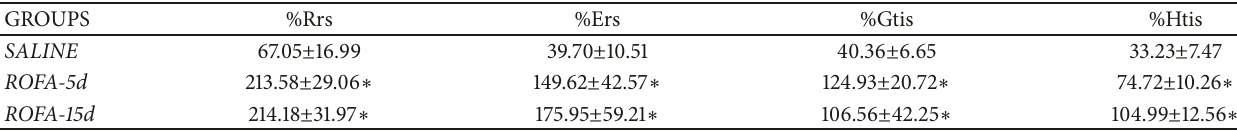
Table 1: ROFA instillation-induced lung mechanics alterations : after both five (ROFA-5d) and fifteen instillations (ROFA-15d), mice presented an increase in the percentage of respiratory system resistance (%Rrs) and elastance (%Ers) as well as in lung tissue impedance (%Htis) and lung tissue resistance (%Gtis) compared to control that received only saline. ∗ p < 0.05 compared to saline (SAL group).